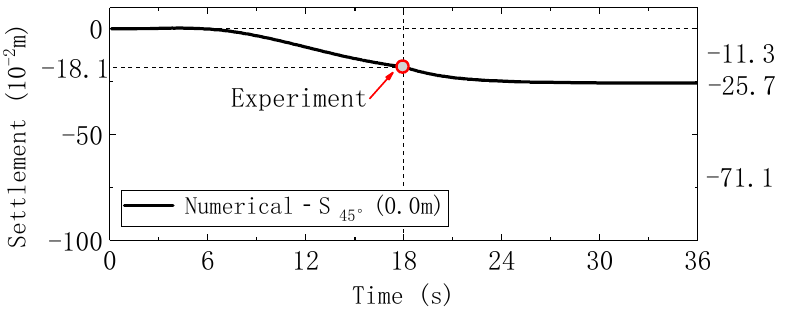
Figure 13. Time history of soil surface settlement.